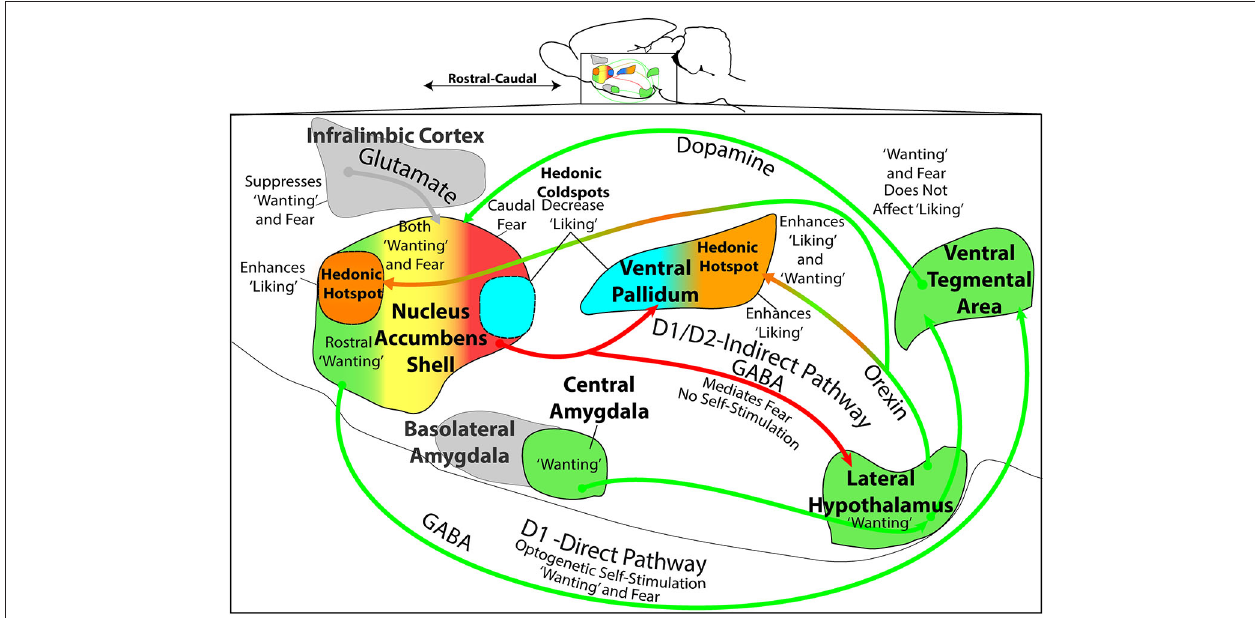
tegmental area (VTA). Optogenetic stimulation of NAc D1-expressing neurons also supports appetitive self-stimulation behavior throughout the entire medial shell. By contrast, NAc glutamatergic generation of fearful behaviors requires additional dopamine stimulation of D2-receptors, implicating indirect path neurons that project to the VP and lateral hypothalamus (LH). The posterior half of VP contains an opioid hedonic hotspot, whereas the rostral half of VP contains a coldspot where mu opioid stimulation suppresses “liking” reactions to sucrose taste. Optogenetic stimulation of the VP hotspot, or of its lateral hypothalamic inputs, may produce enhanced “liking” and “wanting”. Colors denote implication in “wanting” (green), fear (red), mixed “wanting” and fear (yellow), suppression of “wanting” or “fear” (gray), “liking” (orange), or suppression of “liking” (blue). All data from sources described in